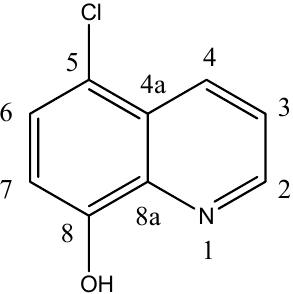
Figure 1. The structure and numbering of 5-chloro-8-hydroxyquinoline.